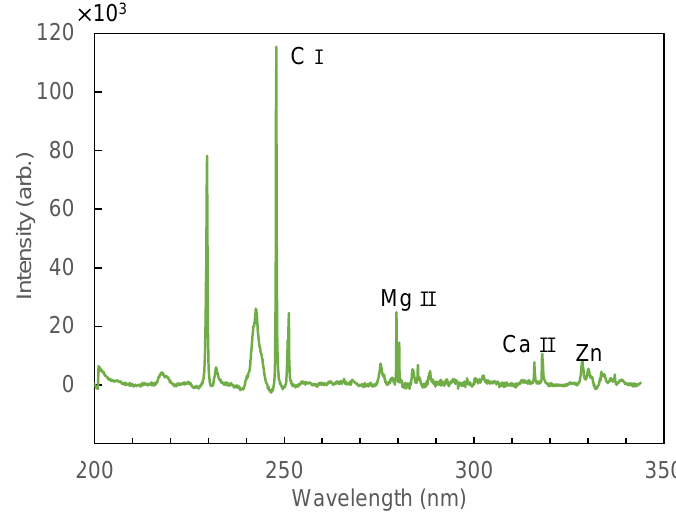
Figure 7. LIBS spectrum of hair measured in the ultraviolet wavelength region.